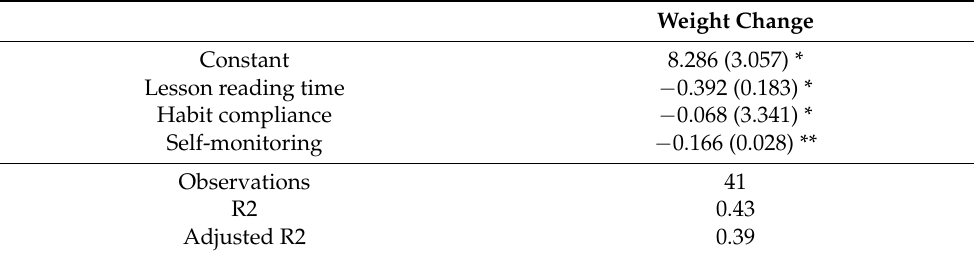
Table 5. Linear regression